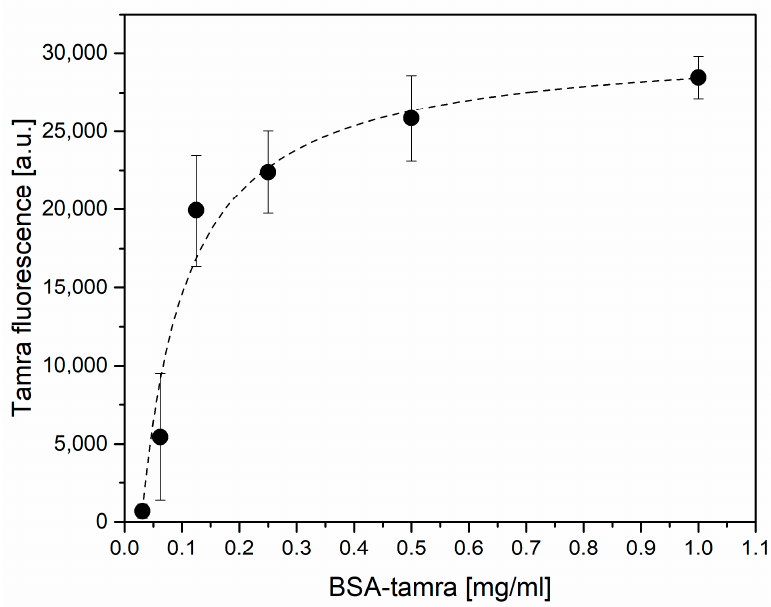
Figure 3. BSA-TAMRA adsorption to antibody functionalized surfaces after 30 min of incubation as a function of different BSA-TAMRA concentrations. Data are reported as the mean value of five images acquired on the samples and the error bars represent standard deviation.